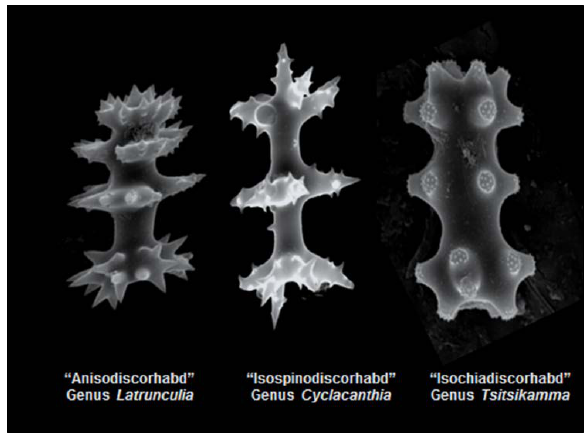
Figure 3: Silicon discorhabd microscleres characteristic of the genus Latrunculia and the two endemic South African genera Cyclacanthia and Tsitsikamma .